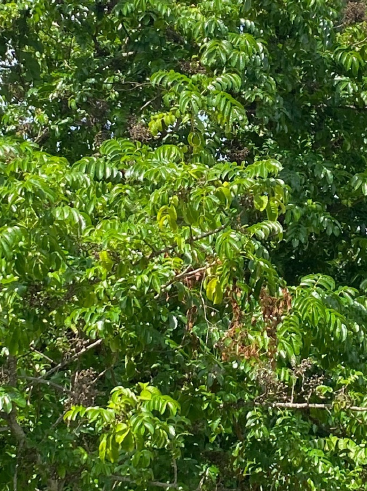
Figure 1. Picture of Zanthoxylum caribaeum (Author: L. Farouil).